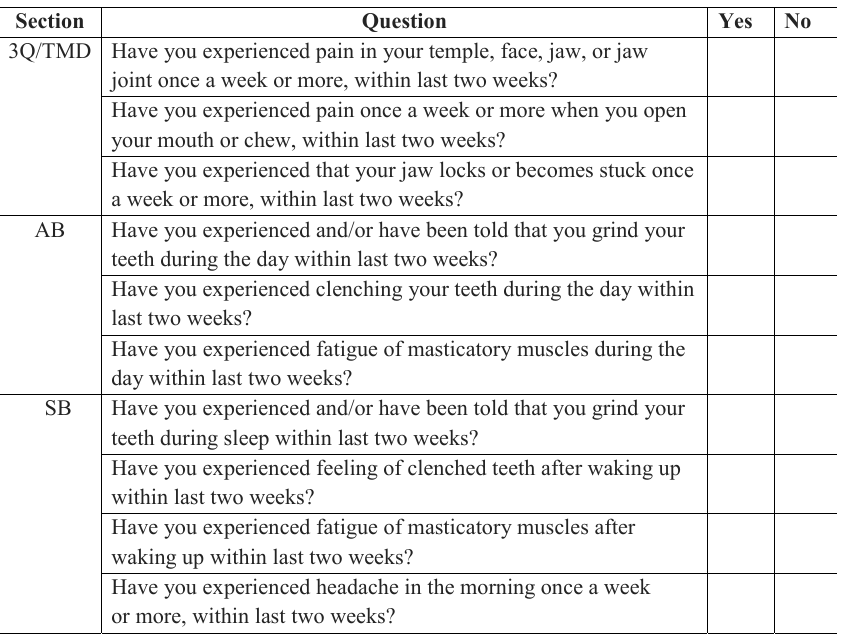
Figure A1. The questionnaire used in the study for screening subjects for TMD symptoms, possible ABW, and possible SB.